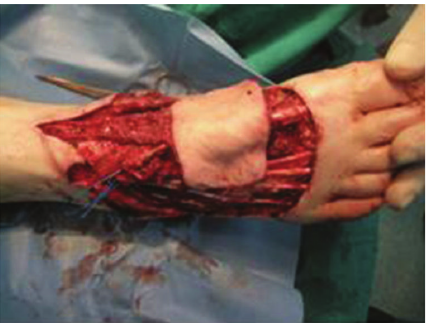
Figure 2: Excision of the lower lip with preservation of the mental nerve.